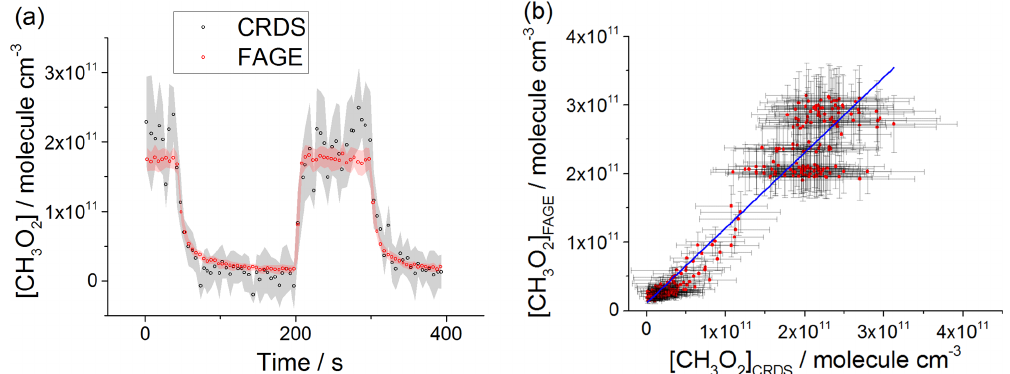
Figure 8. (a) Comparison of CH 3 O 2 measurements at 1000mbar of synthetic air where the lamps were turned off at t ∼ 40s and then on at t ∼ 200s for ∼ 2min before being switched off again. The measurement by FAGE is shown in red and the measurement by CRDS is plotted in black. CH 3 O 2 radicals were generated using the 254nm photolysis of ( CH 3 ) 2 CO (8 . 8 × 10 14 moleculecm − 3 ). The 1 σ statistical errors gen- erated by the data averaging are shown as grey (CRDS) and red (FAGE) shadows. (b) Correlation plot of all the data generated at 1000mbar of air. [CH 3 O 2 ] measured by FAGE is plotted against [CH 3 O 2 ] measured by CRDS. The linear fit to the data is generated using the orthogo- nal distance regression algorithm and results in a gradient of 1 . 09 ± 0 . 06 and an intercept of (1 . 1 ± 0 . 3 ) × 10 10 moleculecm − 3 ; fit errors given at the 2 σ level. In both panels [CH 3 O 2 ] FAGE was determined using a calibration factor of 9 . 81 × 10 − 10 countscm 3 molecule − 1 s − 1 mW − 1 and [CH 3 O 2 ] CRDS was calculated using a cross section of 1 . 49 × 10 − 20 cm 2 molecule − 1 . Each point is a value averaged over